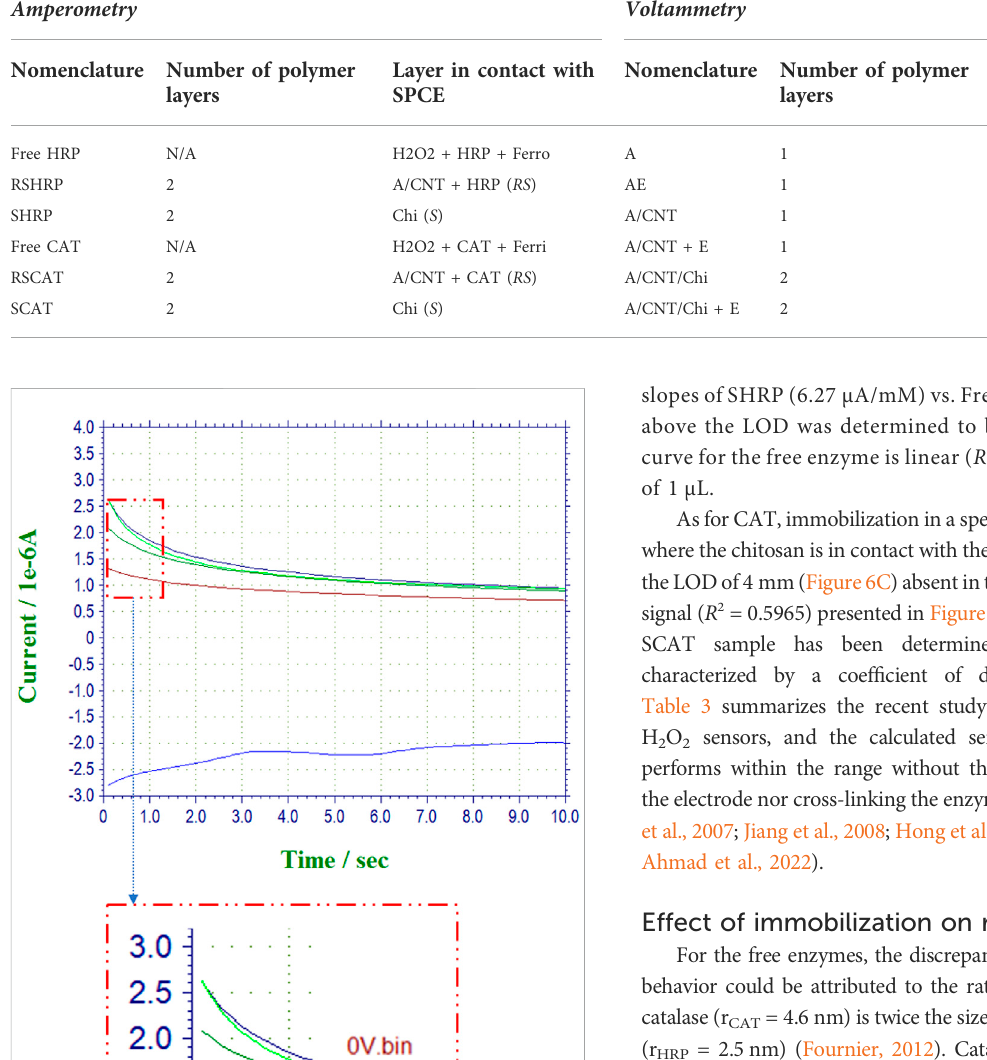
TABLE 1 Sensor composition and stacking order with respected to contact with SPCE.